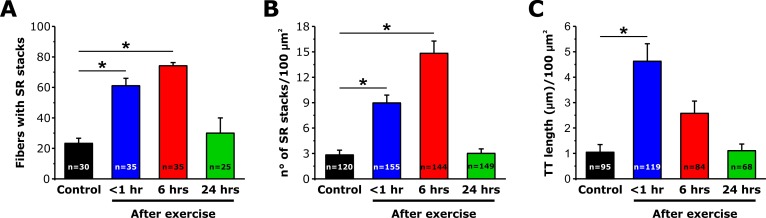
SR-stack incidence, number/area, and T-tubule length after exercise.Quantitative analysis of the percentage of muscle fibers exhibiting SR stacks (A), number of SR stacks per 100 μm2 of cross sectional area (B), and TT length in the I band (μm/100 μm2 of cross sectional area) (C) determined from EM images of fibers from fixed FDB muscles from control mice and mice < 1 hr, 6 hr, and 24 hr after acute treadmill exercise. Numbers in bars (n) indicate the number of FDB fibers analyzed. Number of mice used: Control, n = 3;<1 hr after exercise, n = 3; 6 hr after exercise, n = 4; 24 hr after exercise, n = 3; *p<0.05. Data are shown as mean ± SEM.